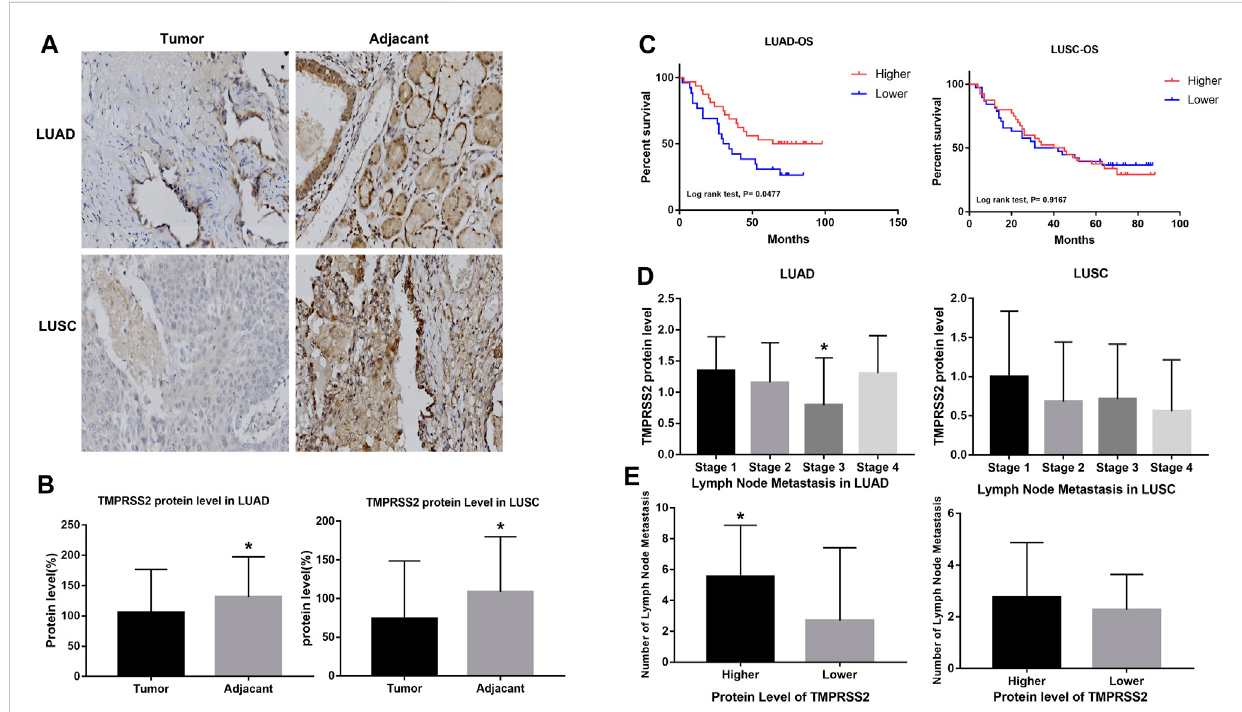
FIGURE 2 Higher expression of TMPRSS2 protein was correlated with different clinicopathological parameters in LUAD and LUSC cohorts. (A) ImmunohistochemicalstainingforTMPRSS2oftumorandadjacenttissueinLUADandLUSC.Originalmagni fi cation×40.TMPRSS2proteinlevelintumor and adjacent (B) and overall survival (C) of LUAD and LUSC, * p < 0.05. (D) Correlation between TMPRSS2 protein level and clinical stage, * p < 0.05. (E) Correlation between TMPRSS2 protein level and lymph node metastasis, * p <